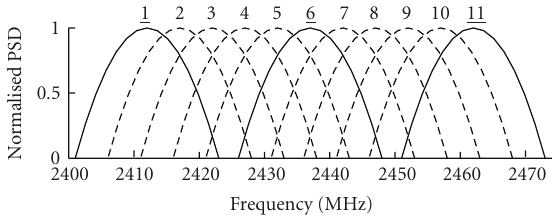
Figure 1: Available eleven channels of fixed predetermined width defined in 802.11 b/g standards.